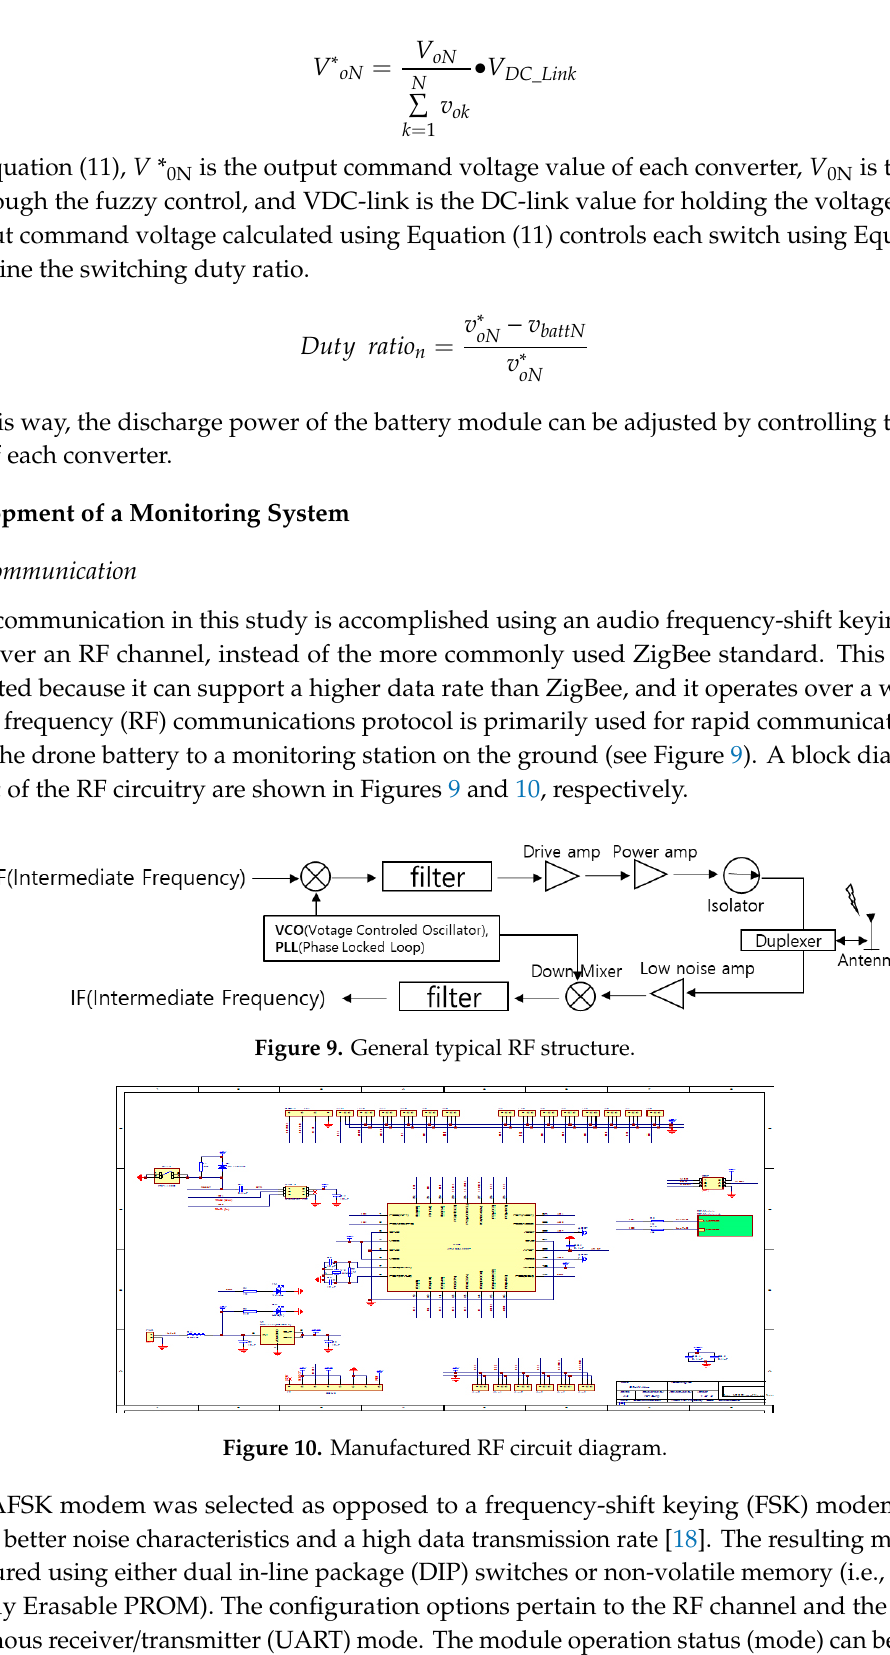
( b ) Figure 11. Testing prototype ( a ) and the transmission/reception module when mounted on an agricultural drone ( b ). The transmitter/receiver system shown in Figures 12 and 13 was developed to serve as a wireless base station and receive data related to battery usage via the RF sensor installed on the drone. The system receives the voltage output (0–3.3 V) from the current sensor and converts it into current using an analog-to-digital converter (ADC) before outputting the data. The conversion ratio of 6.6 mV/A translates to a 6.6 mV change per 1 A of current sensed per mV. An output of 0 V translates to 200 A, an output of 1.65 V represents 0 A, and an output of 3.3 V translates to 200 A.